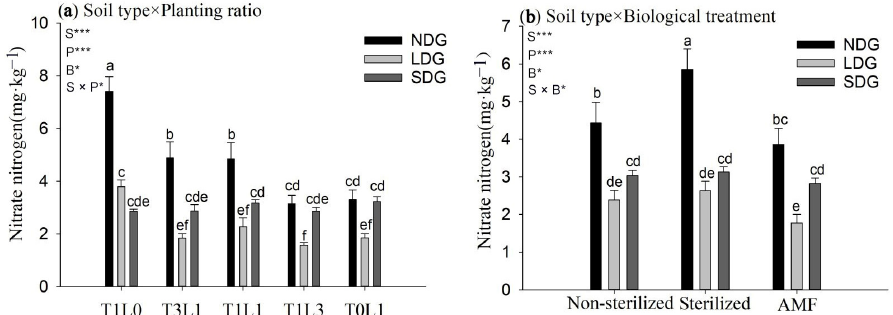
Figure 8. Effects of different treatments on soil NO 3– -N content. ( a ) Effects of soil type (S), planting ratio (P) and their interactions (S × P) on soil nitrate nitrogen concentration. ( b ) Effects of biological treatment (B) on soil nitrate nitrogen concentration. Different letters indicate the significant differences among treatments ( p < 0.05). *** p < 0.001, * p < 0.05, p < 0.1 indicate the significance level of each treatment. Note: soil degradation degree (S); planting ratio (P); soil biological treatment (B); NDG: non-degraded grassland; LDG: lightly degraded grassland; SDG: severely degraded grassland. T1L0, T3L1, T1L1, T1L3, T0L1 mean planting ratio of T. repens and L. perenne : 1:0, 3:1, 1:1, 1:3, 0:1,